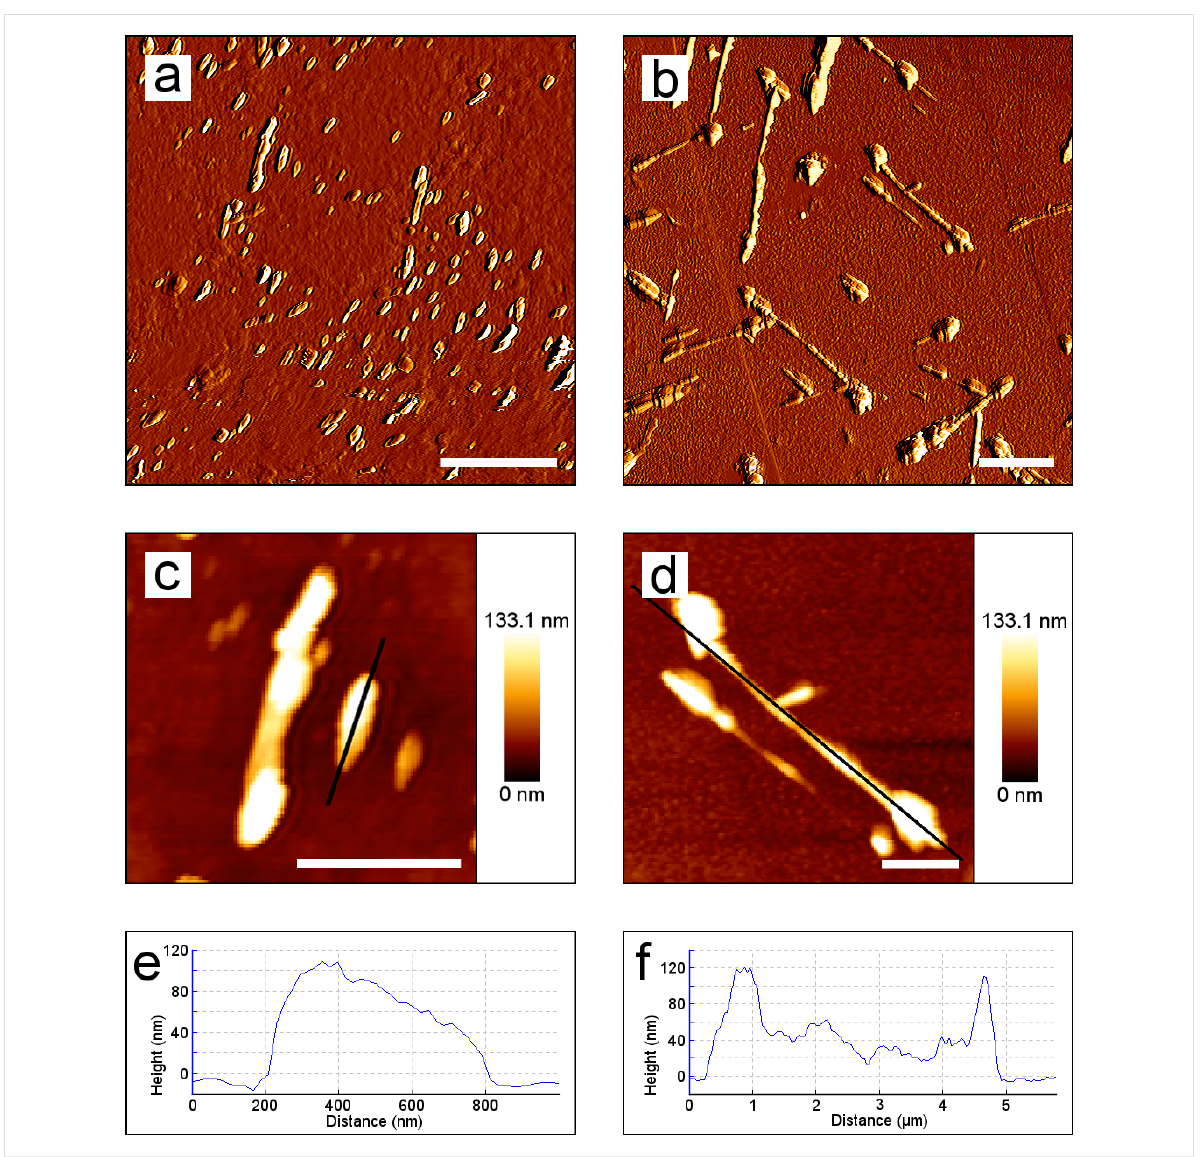
Figure 3: AFM images of recrystallized wax on HOPG. Two kinds of platelets were detected: (a,c,e) shorter platelets with varying shapes of the top edges; (b,d,f) longer platelets with deeply grooved top edges. (a) Platelets arranged in one direction after 50 min. (b) Platelets arranged parallelly or and in acute angles, 4 h and 28 min after the application of the wax solution. (c,d) Detailed view of the platelets with the corresponding longitudinal section analysis (e,f). Scale bars in (a,b): 2.5 µm, in (c,d): 1